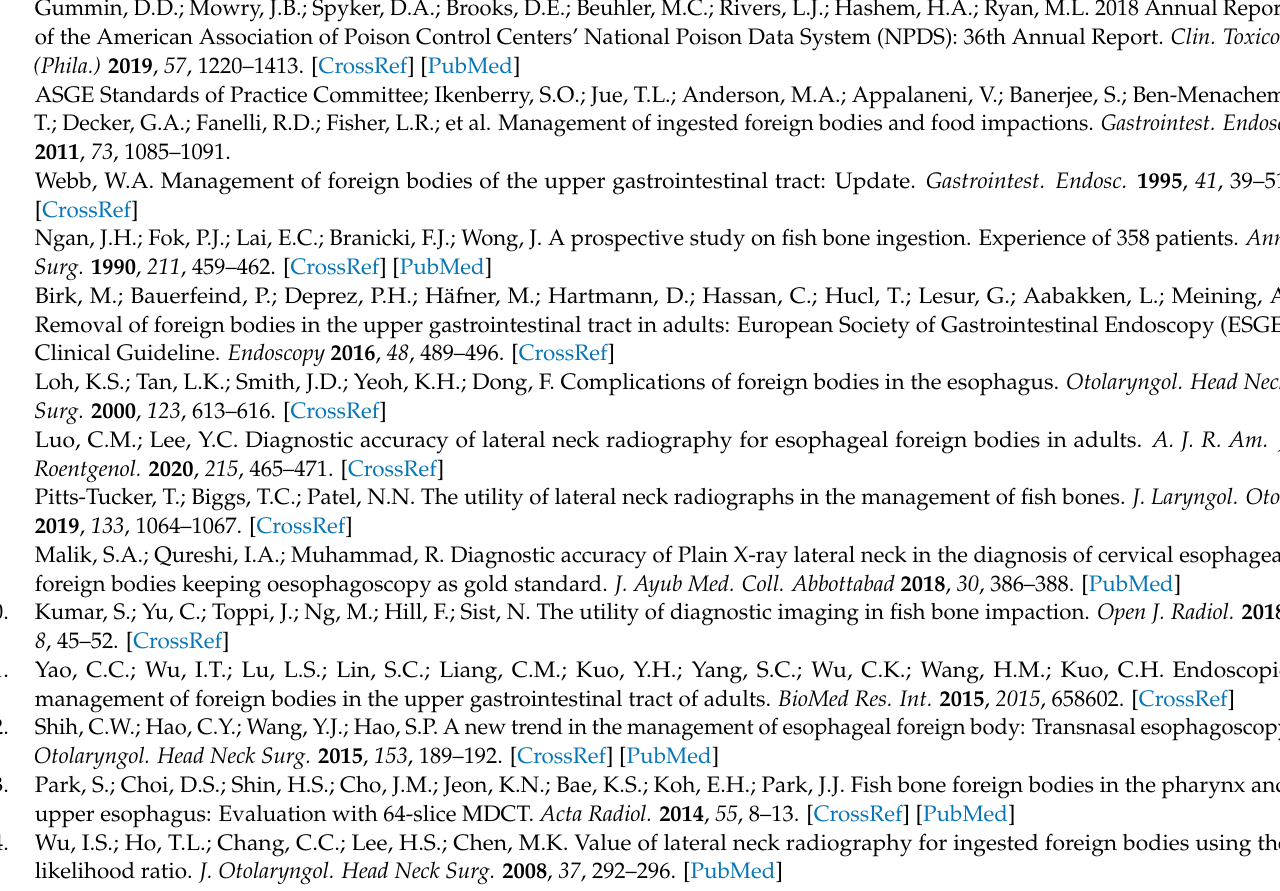
Figure S1: The methodological quality of the included 17 studies, Figure S2: Deeks’ funnel plot asymmetry test for publication bias, Figure S3: Sensitivity analysis after the exclusion of five studies with a sample size of